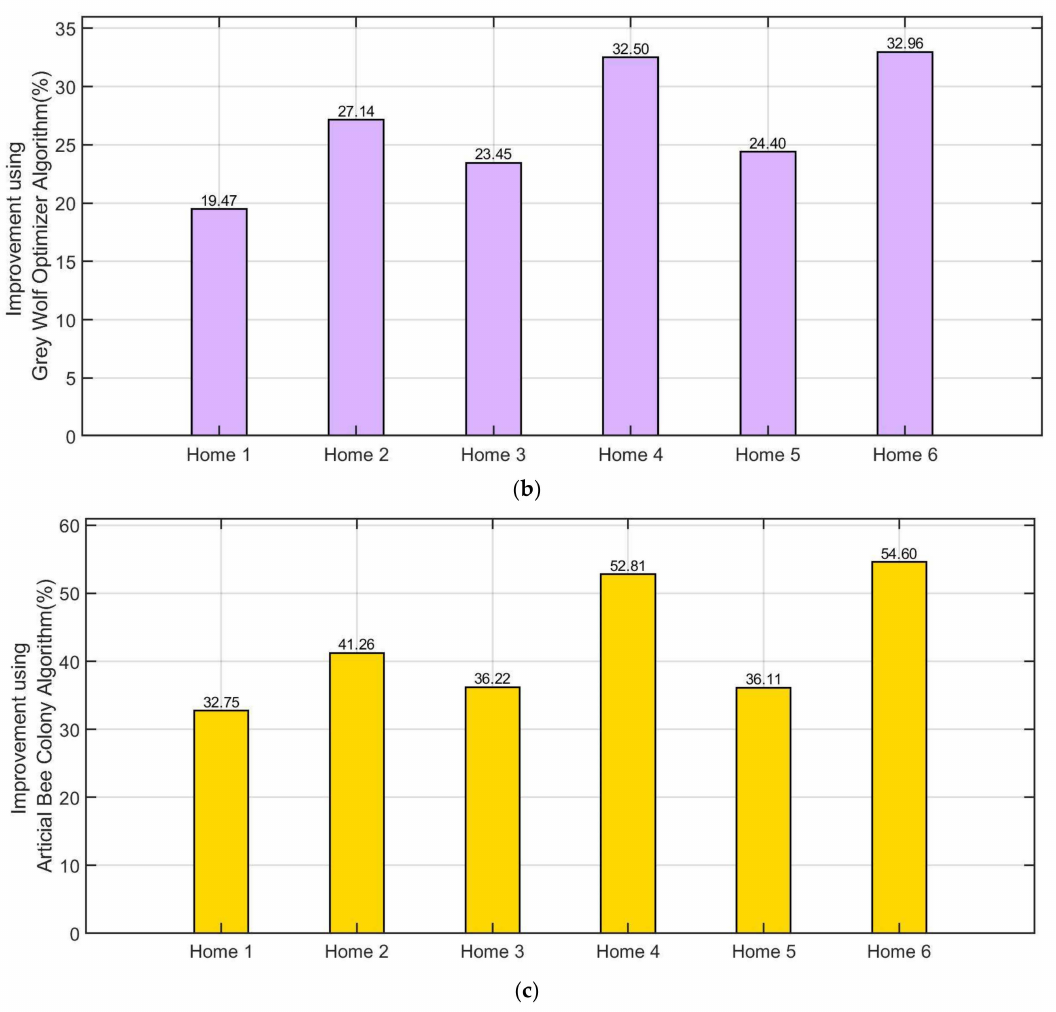
Figure 14. Comparison between without suggested EMS and with suggested EMS, ( a ) microgrid cost, ( b ) improvement (%) by using GWO and ( c ) improvement (%) by using